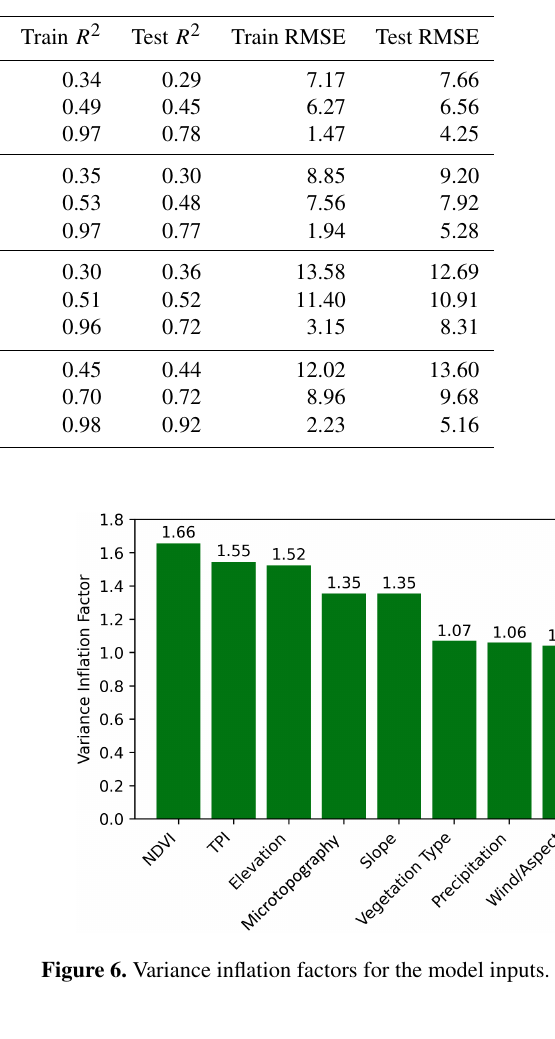
Table 3. Comparison of model performance for linear regression, GAM, and random forest models that are trained on individual years and individual sites.